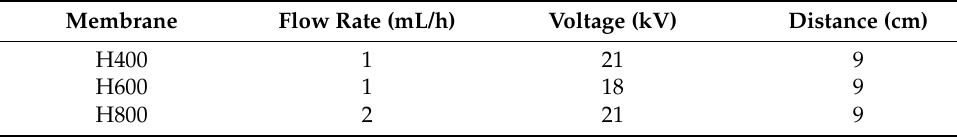
Table 1. Electrospinning parameters of HA-Bn